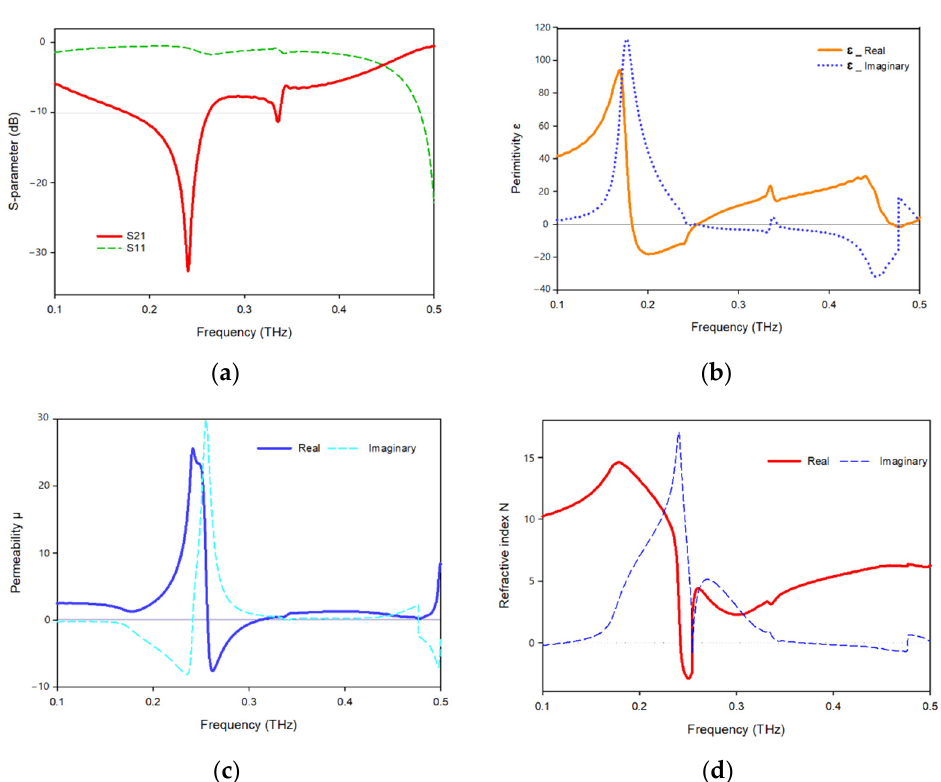
Figure 13. Y -axis effective parameter: ( a ) S-parameter; ( b ) permittivity; ( c ) permeability; ( d ) refrac- tive index. tive